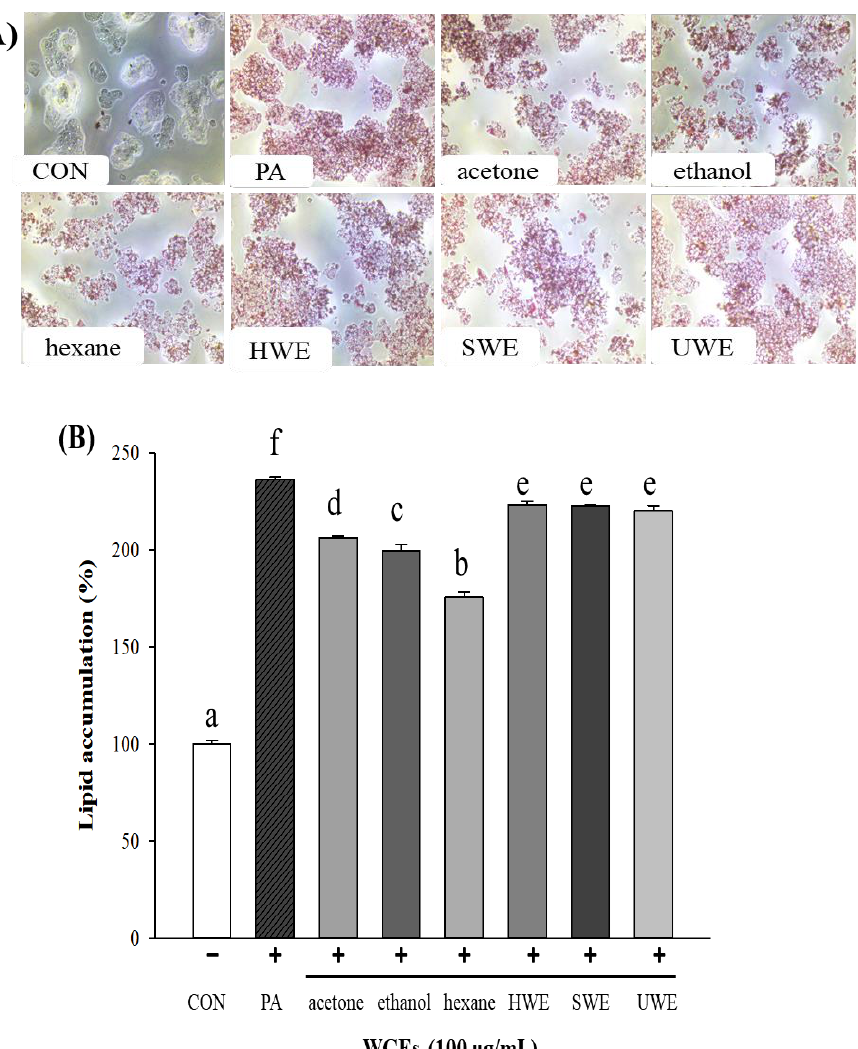
Figure 4. Effect of wheat germ extracts (WGEs) on cellular lipid accumulation in palmitic acid (PA)-induced steatosis in HepG2 hepatocytes. ( A ) The morphology of stained intracellular lipid droplets by ORO staining at 400× magnification. ( B ) The content of cellular lipid accumulation stained by Oil Red O (ORO). Different letters indicate significant differences at p < 0.05 determined by Duncan’s multiple range test. CON, control; HWE, hot water extract; SWE, subcritical water extract; UWE, ultrasonic water extract.